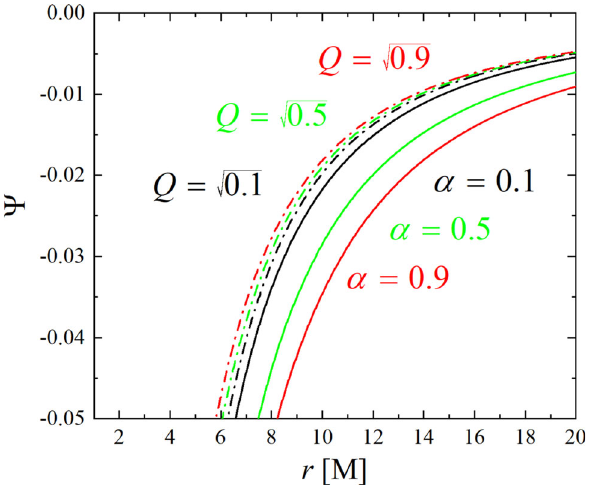
Fig. 16 Gravitational force Ψ plotted versus radius r for Schwarzschild-MOG BHs (solid line) and RN BHs (dashed line). Here we take G N = M = c =